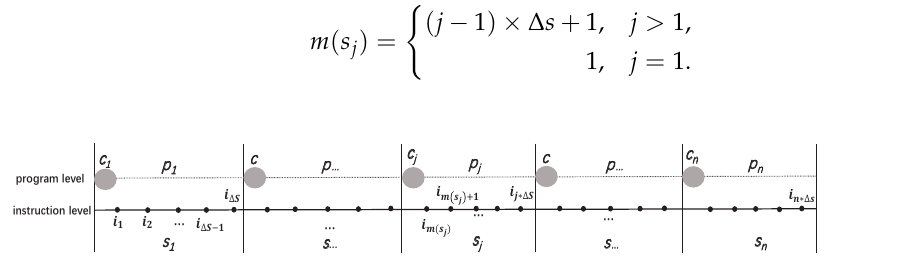
Figure 7. The division of program